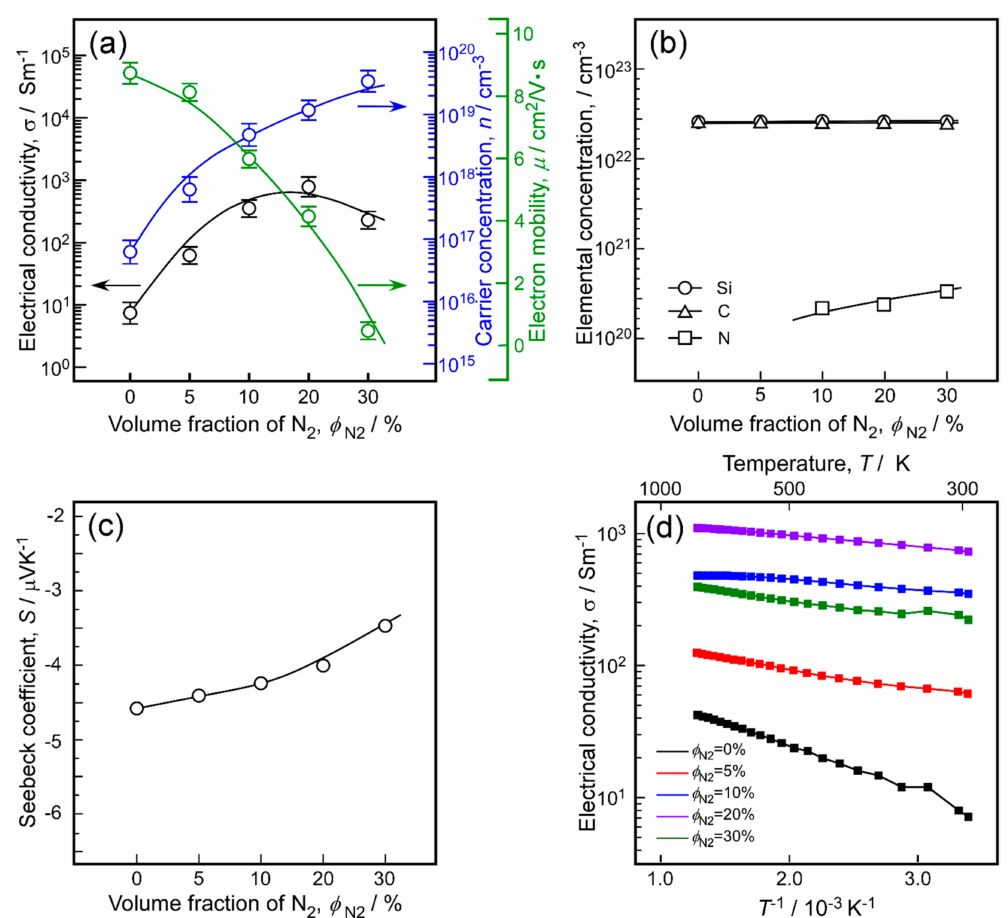
Figure 7. E ff ect of φ N2 on electrical conductivity, carrier concentration, and mobility ( a ), elemental compositions ( b ), and Seebeck coe ffi cient ( c ) of N-doped 3C-SiC bulks. ( d ) Temperature dependence of electrical conductivities of N-doped 3C-SiC